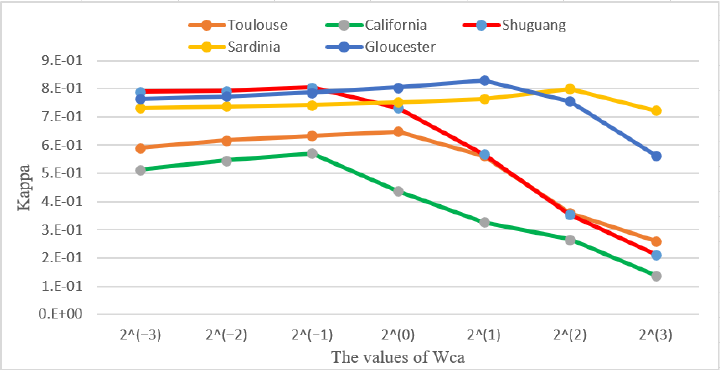
Figure 14. Influences of parameter ω ca on the CACD